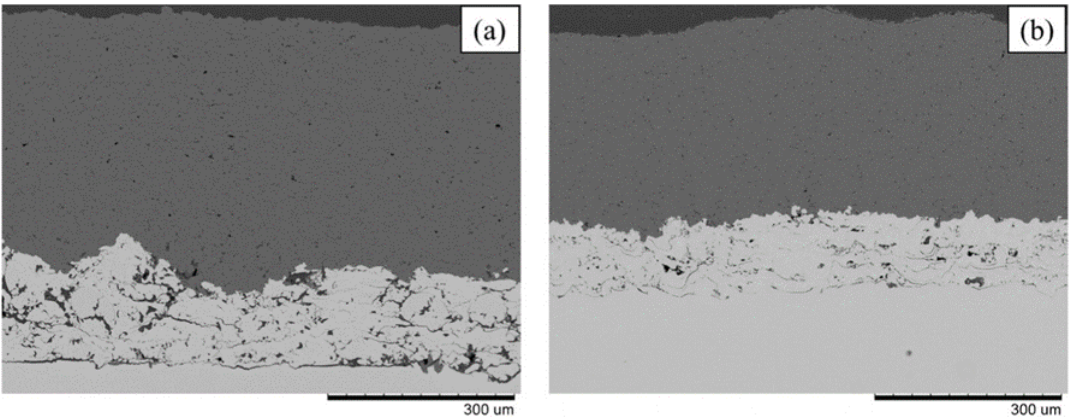
Figure 11. SEM image of cross section of; ( a ) APS Al 2 O 3 ; and ( b ) SPS Al 2 O 3 [149]. Reprinted with permission from [149]. © 2017 Elsevier. Coatings 2019 , 9 , x FOR PEER REVIEW